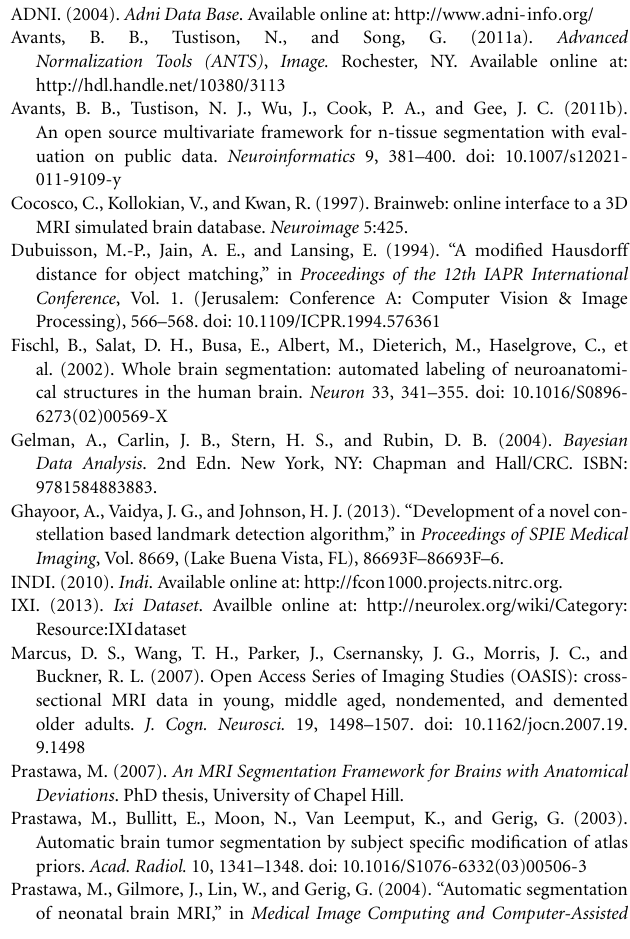
T1 and T2. Real data, however, presents the globus pallidus (orange) with medium gray in T1 and dark gray in T2. (A) Simulated T1; (B) In-vivo T1; (C) Simulated T2; (D) In-vivo